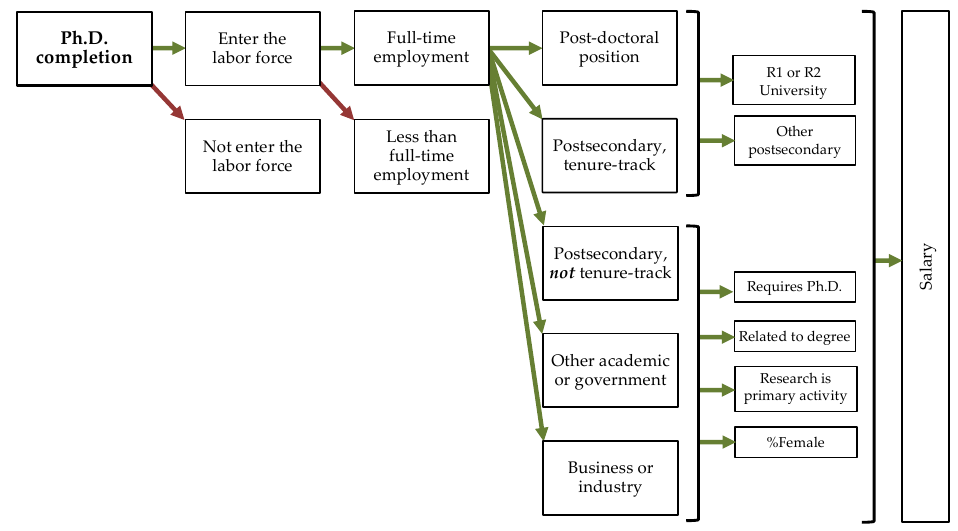
Figure 1. Schematic representation of post-doctoral employment transitions and outcomes.